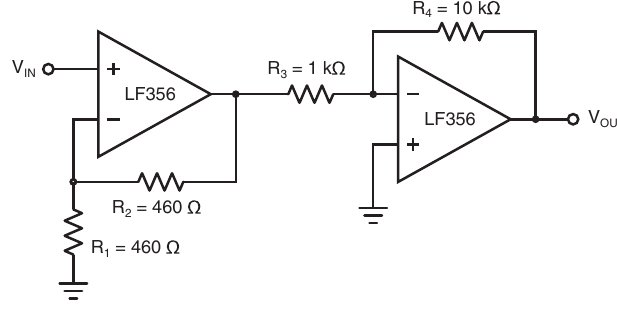
FIG. 5. Schematic diagram of inverting cascade amplifier, provided to study participants during the TAPPS activity. The diagram was accompanied by the following text: “ Figure 1 is a schematic of the inverting cascade amplifier we built. The [output] of this circuit is [given by Eq. (1)]. The main advantage of a cascade amplifier over a regular amplifier is that we can achieve high gain while maintaining a relatively large bandwidth. Disadvantages of this circuit compared to the regular amplifier include more components and increased power consumption.